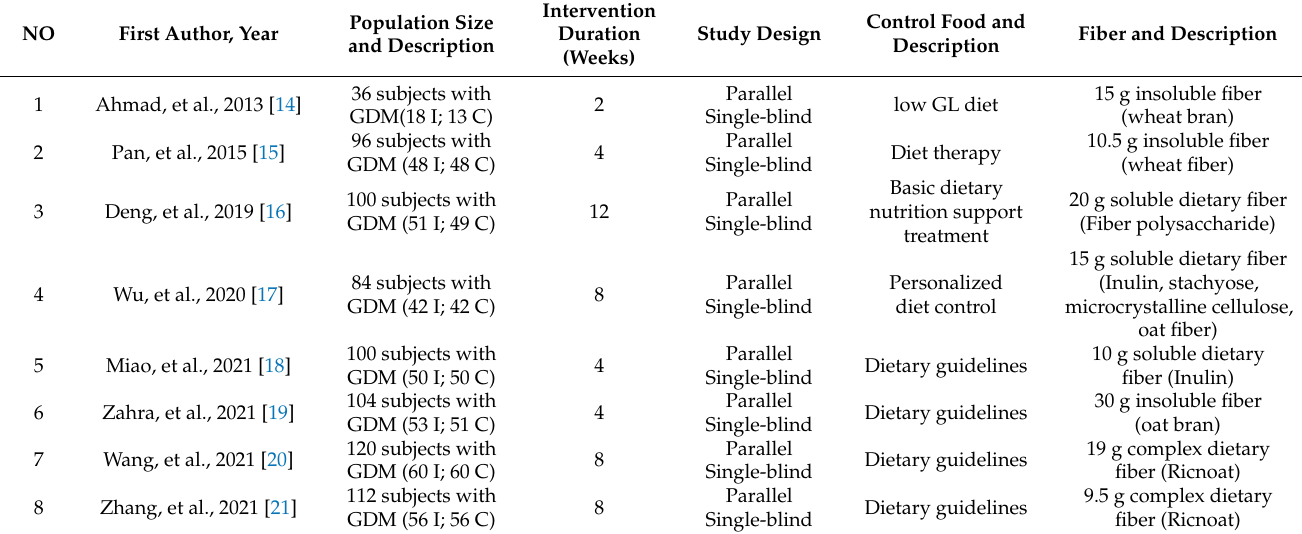
Table 1. Study characteristics of the eight included articles.